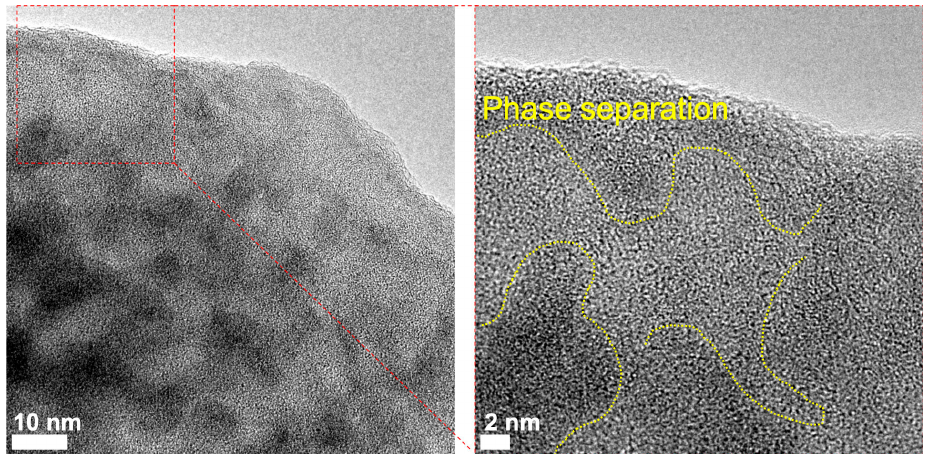
Figure 5. TEM image of the Au-doped glass sample heat treated at 750 °C for 20 h. The right image depicts magnified region in red.